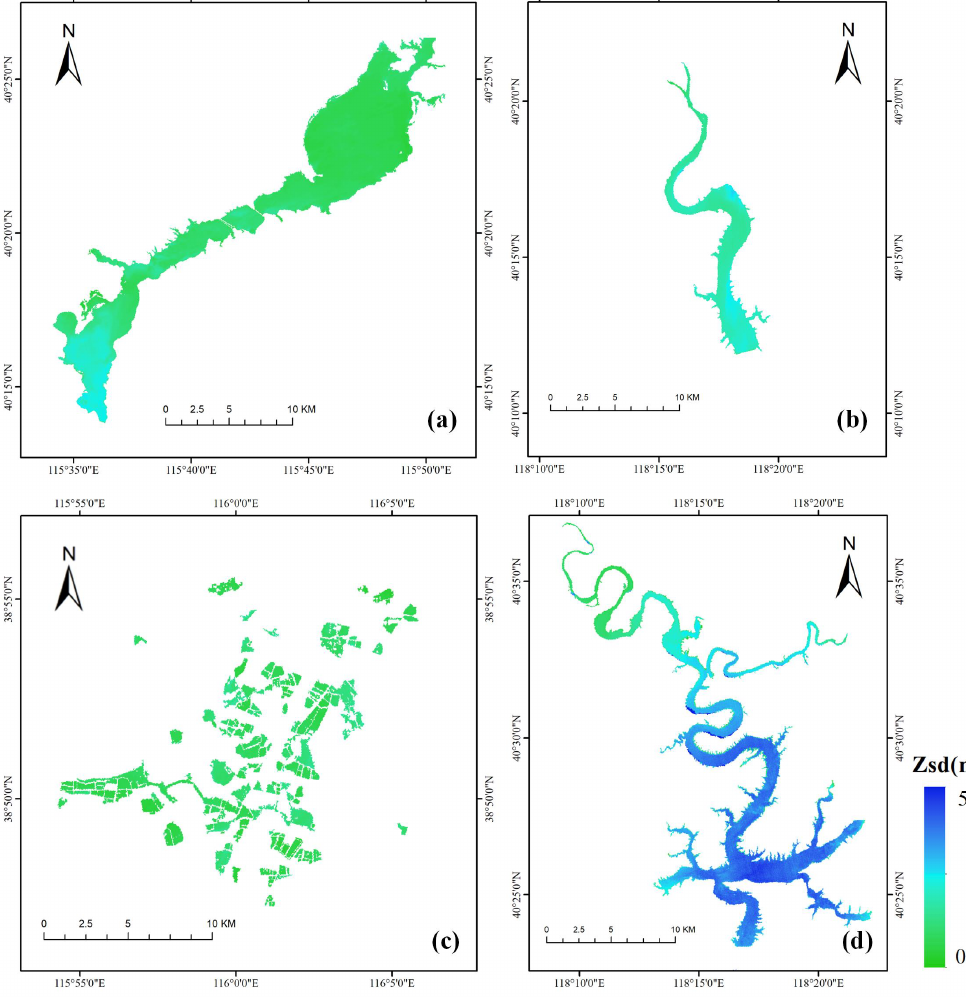
Figure 5. Z sd images of AHSI sensor based on semi-analytical method with QAA V 5